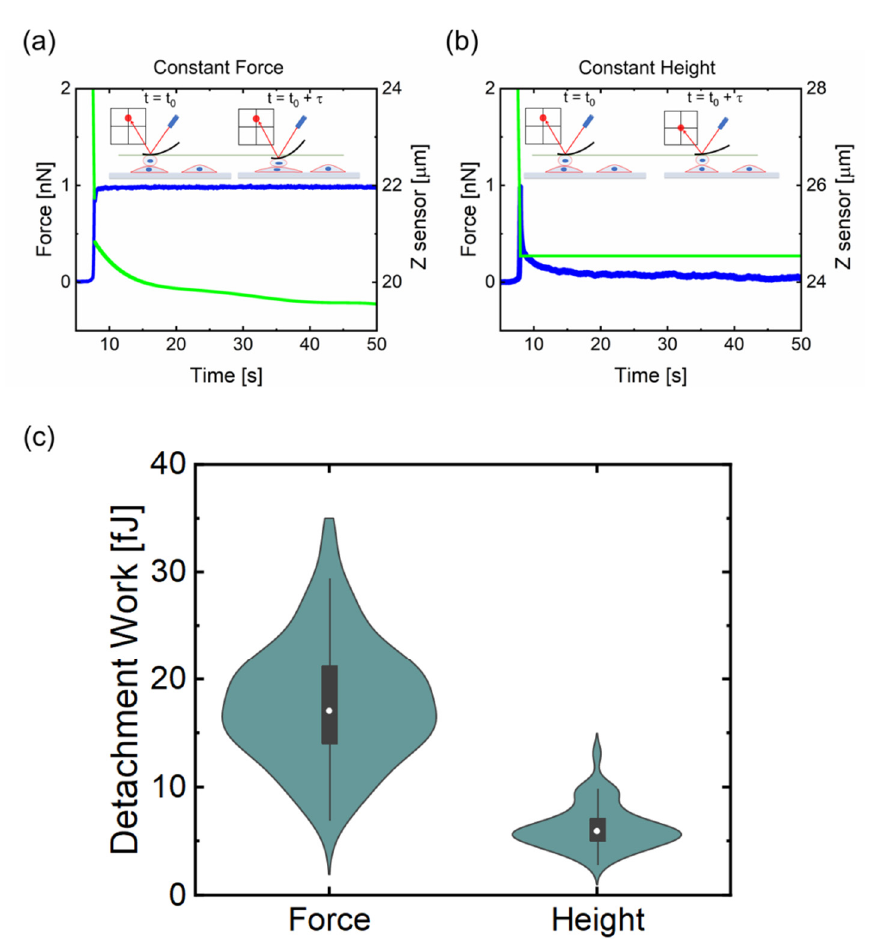
Figure 3. Influence of the two different delay modes on cell–cell interactions. When cells are kept under a constant applied force during the contact time (blue line in ( a )), they reshape their structure resulting in a compensatory decrease in the relative piezo displacement signal (green line). In contrast, when it is kept constant the separation between the AFM cantilever and the sample (green line in ( b )), the vertical deflection signal in the photodiode initially increases to reach the preset force setpoint (blue line) to, subsequently, decrease during the contact time. ( c ) shows the distribution of the work spent to detach the probe cell from the target cell when both delay modes are in- vestigated.